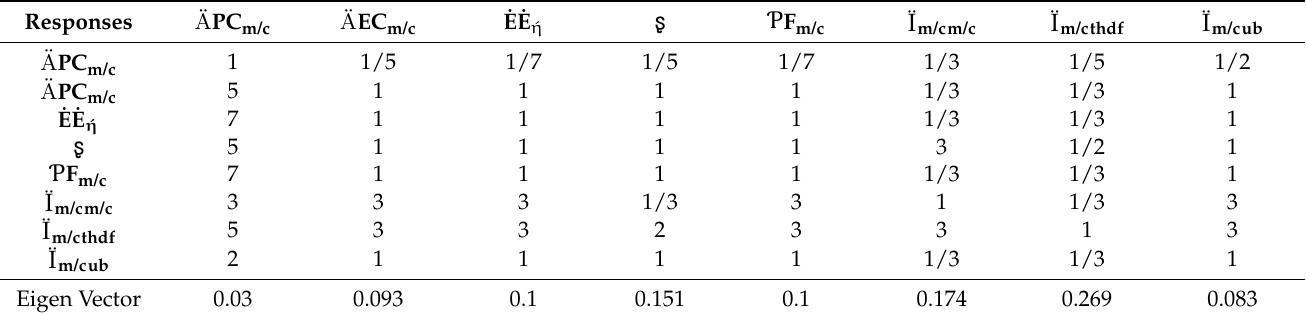
Table 15. Pairwise comparison